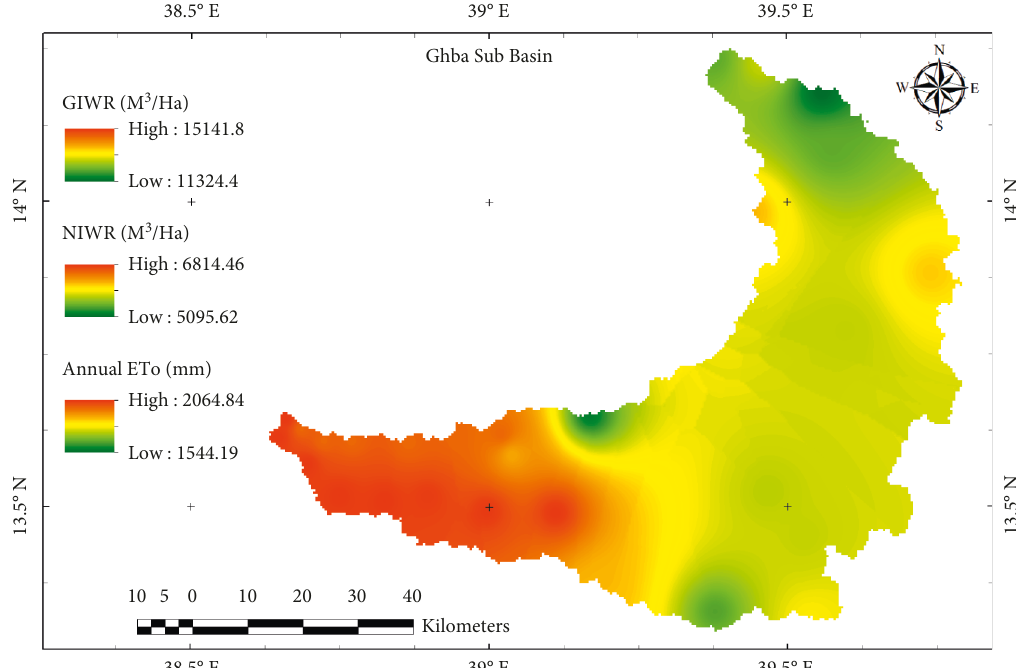
Figure 7: Annual ETo, current NIWR, and current